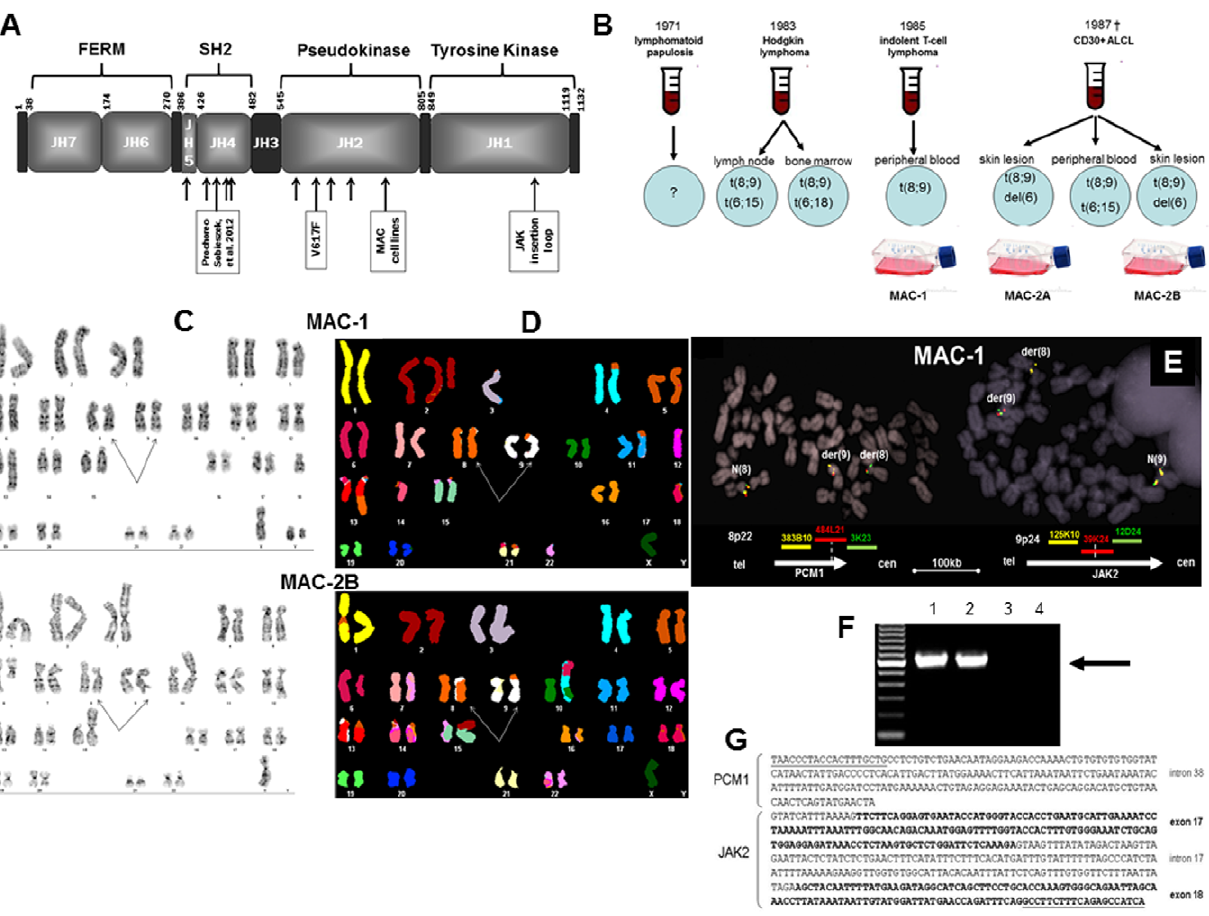
Figure 1. Genomic analysis. A : Depicts the domain structure of JAK2 (amino acid numbering based on Chen et al. [2]. Arrows show breakpoints reported in MAC cells and t(8;9) patients. B : Diagrammatic history of t(8;9) observed in the donor patient and derived cell lines at various times throughout the course of disease. t(8;9) was accompanied by various chromosome 6 rearrangements. Analyses were based on classical methods only. C : G-banding, and D : SKY analyses of MAC-1 and MAC-2B cells which were the most similar to MAC-2A (not depicted). Arrows show t(8;9). E : Shows FISH using BAC clones flanking and straddling PCM1 (left) and JAK2 (right): Note breaks (split signals) within RP11-484L21 (PCM1) and RP11-39K24 (JAK2). F : Shows gPCR for PCM1-JAK2 unique to MAC-1/2A/2B, and G : sequencing of the genomic PCR product of t(8;9) breakpoints in PCM1 and JAK2. Abbreviation: NTC, no template control.